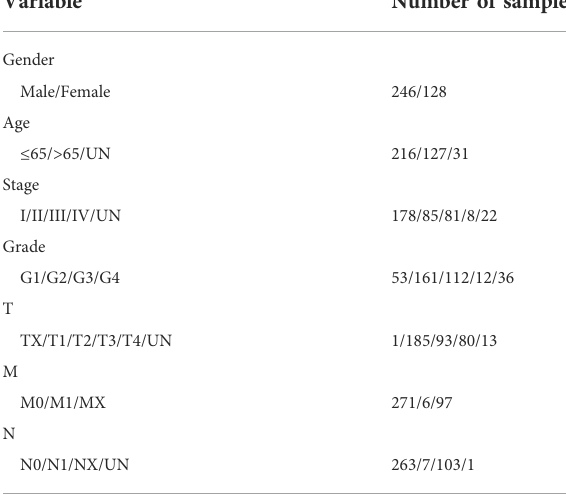
TABLE 1 The clinical characteristics of patients in the TCGA